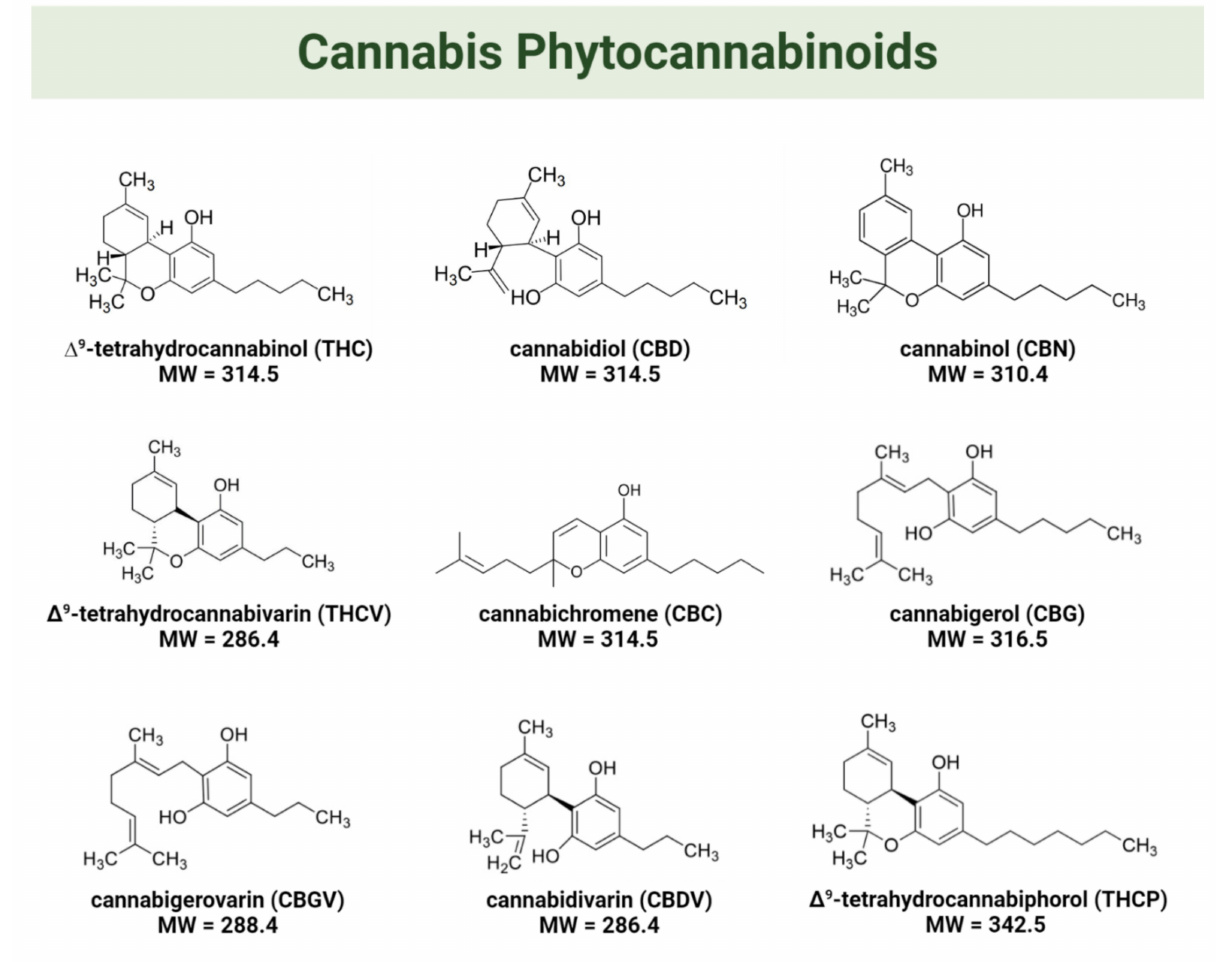
Figure 1. Molecular structures of phytocannabinoids found in